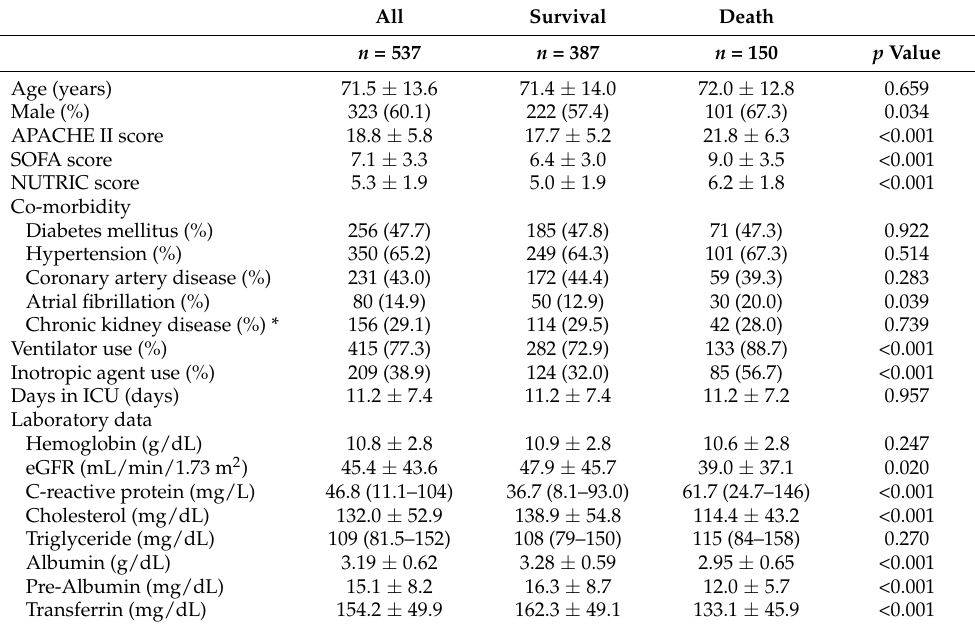
Table 1. Demographic and laboratory data for the initiation